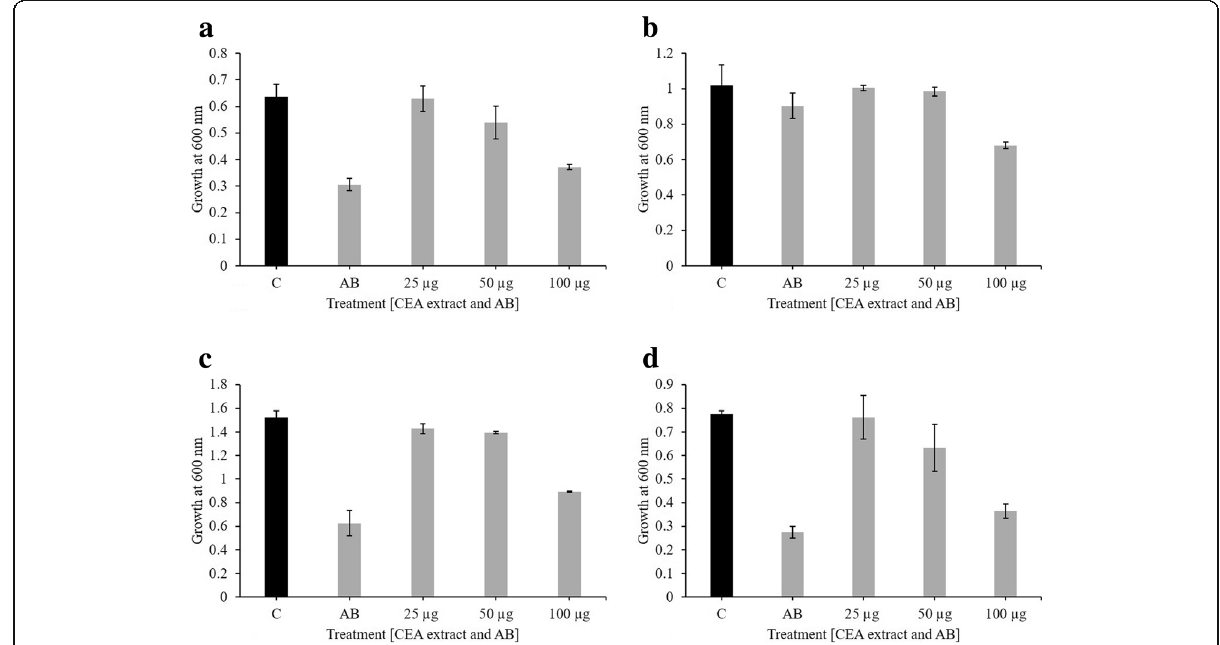
Fig. 2 Antibacterial activity of CEA extract through broth microdilution method. The picture shows the effect of 25, 50 and 100 μ g/ml of CEA extract on the growth of ( a ) E. coli strain 1 ( b ) E. coli strain 2 ( c ) E. coli strain 3 and ( d ) ATCC strain of E.